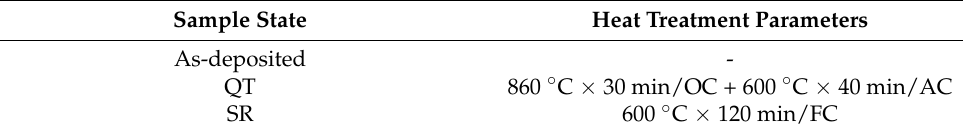
Table 2. Heat treatment process of 24CrNiMo alloy steel